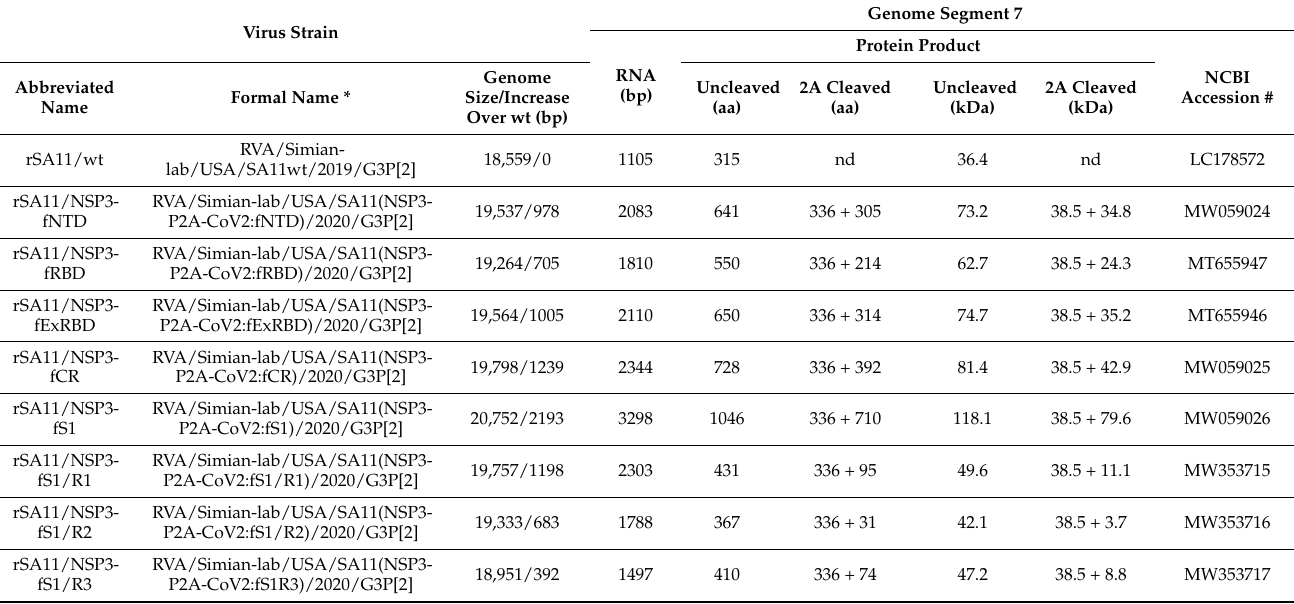
Table 2. Properties of recombinant rRV/NSP3-2A-CoV2